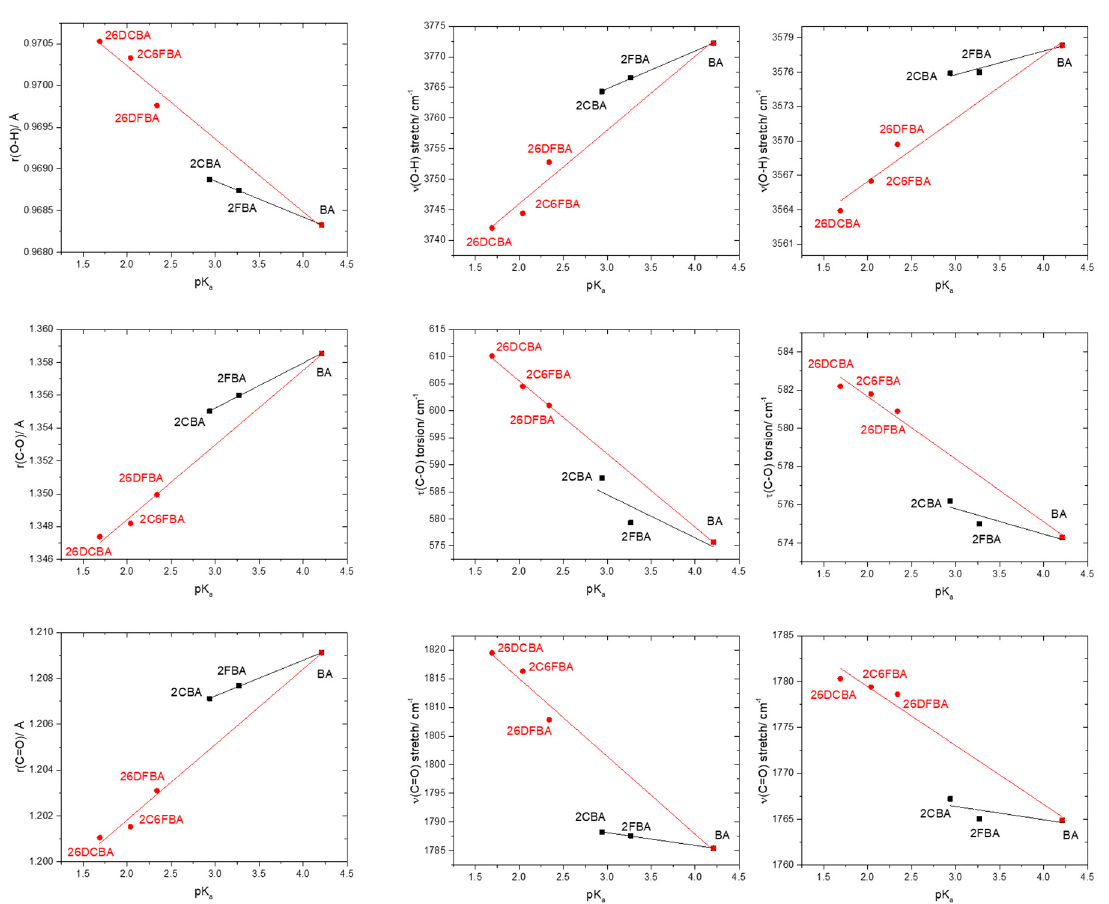
Figure 10. Correlation between the O-H, C-O and C=O bond lengths and of the ν (O-H), τ (C-O), and ν (C=O) vibrational frequencies of the experimentally relevant cis conformers and pK a values (water; 25 °C) for the studied molecules. From top-left to bottom-right panels (descending by columns), the slopes, intercepts of the fitted lines and the R 2 parameters of the adjustements are: ( − 4.318 × 10 –4 , 0.970, 0.99897; − 8.755 × 10 –4 , 0.972, 0.97477), (2.750 × 10 –3 , 1.347, 0.99982; 4.550 × 10 –3 , 1.339, 0.99409), (1.560 ×